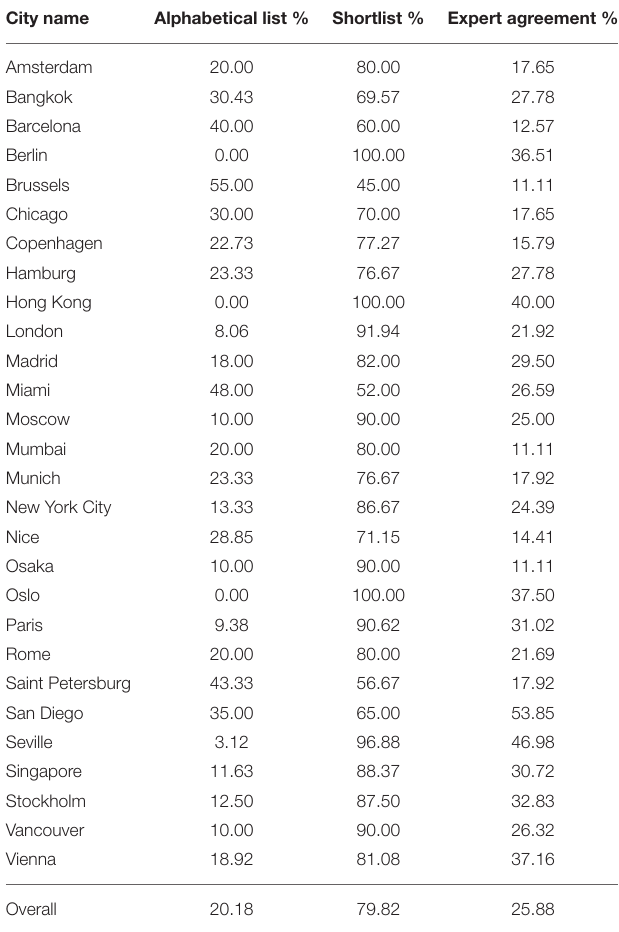
TABLE 3 | Expert annotators behavior: amount of cities selected from the shortlist vs. the full alphabetical list and percentages of the same cities